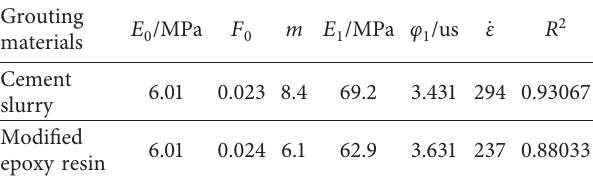
Table 6: Fitting